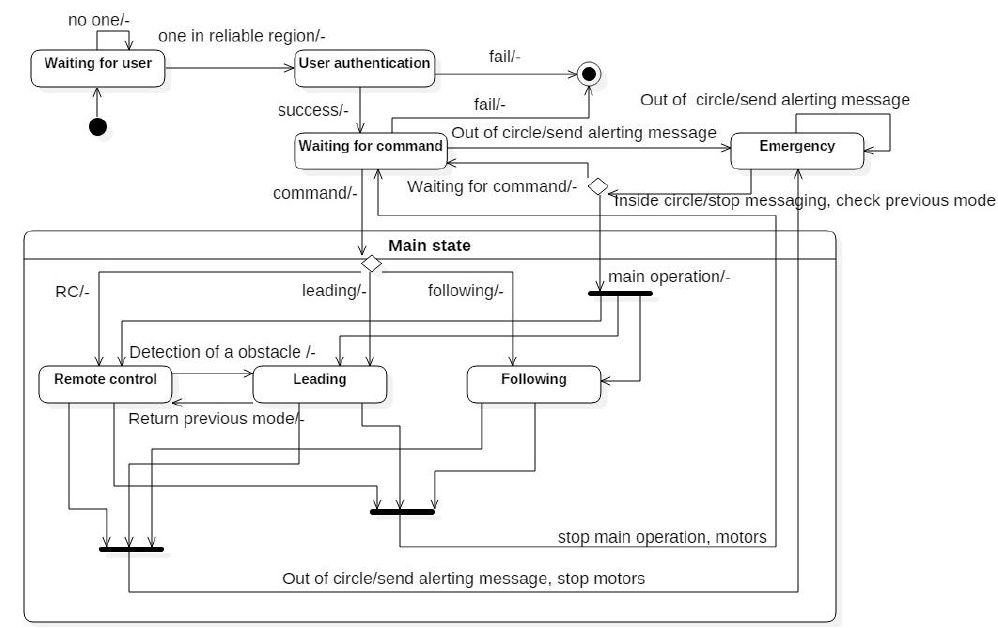
Figure 4. State diagram of a mobile robot.